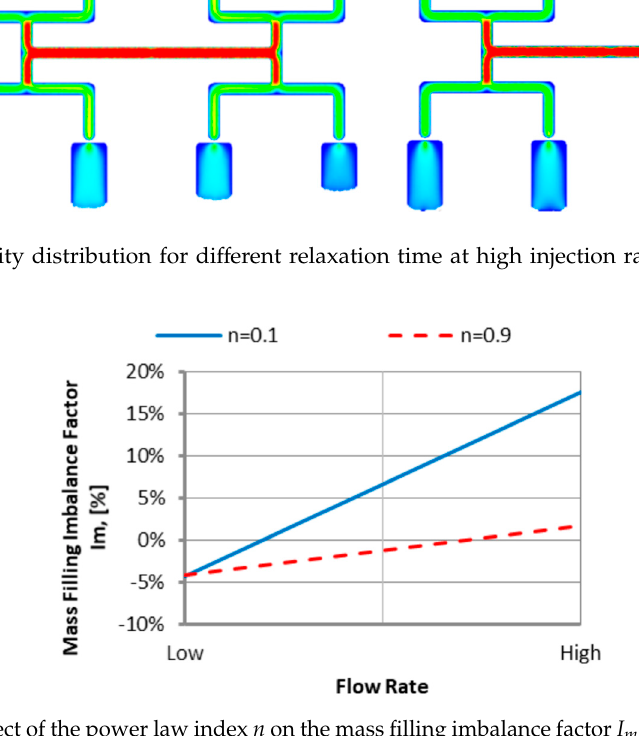
Figure 14. Velocity distribution for different relaxation time at high injection rate: ( a ) λ = 0.001 s, ( b ) λ = 0.1 s.